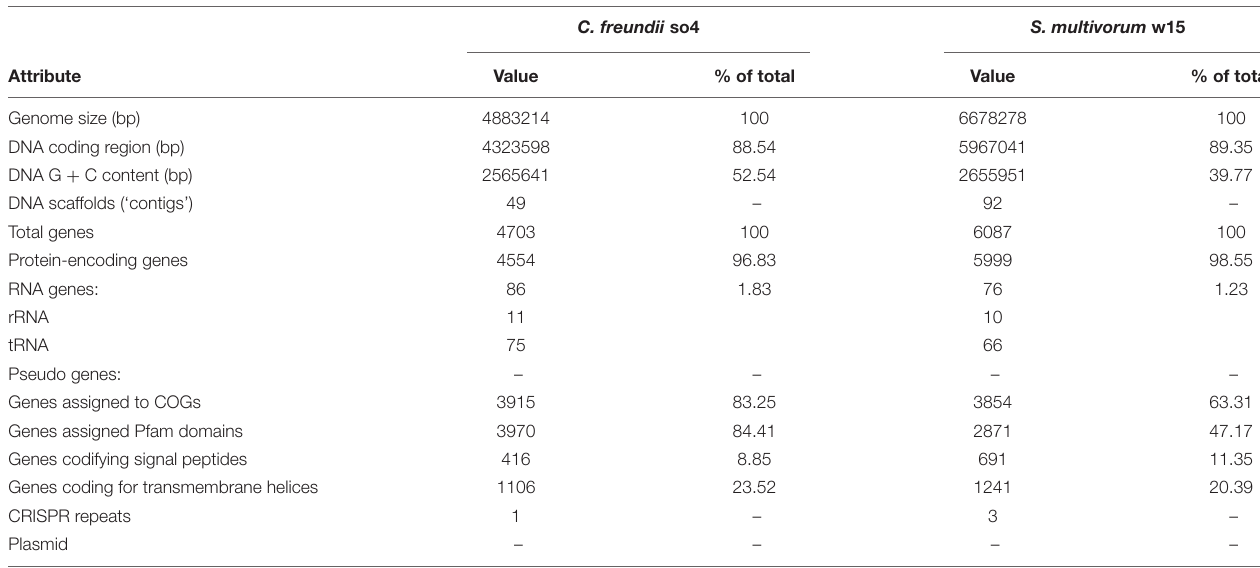
TABLE 1 | Genome statistics of C. freundii so4 and S. multivorum